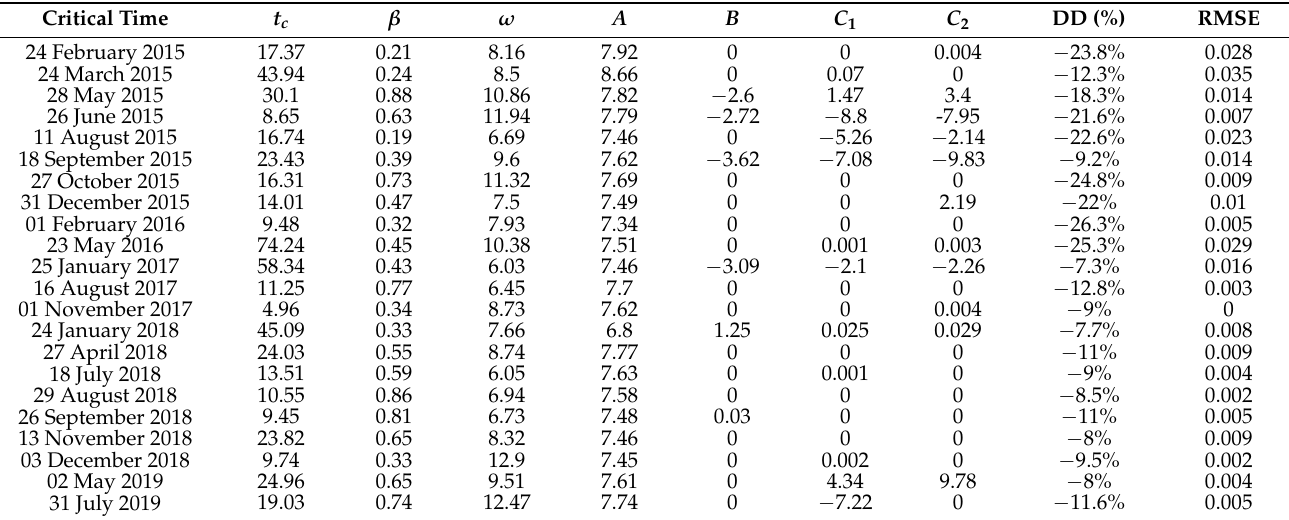
Table 4. Coefficients of the LPPL framework providing a drawdown of >7% in Greece. Critical